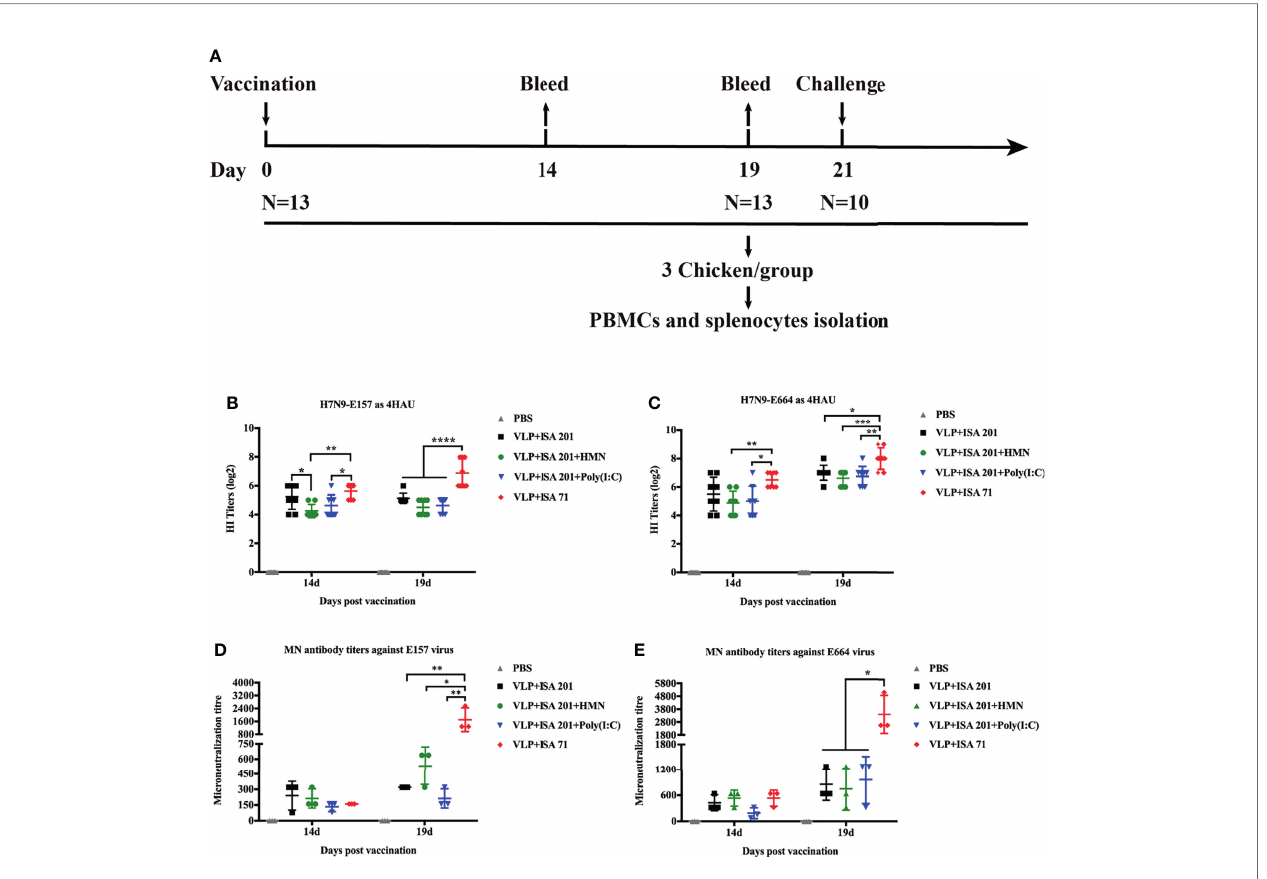
FIGURE 5 | Hemagglutinin inhibition (HI) and neutralizing antibody titers of immune sera from vaccinated speci fi c pathogen-free (SPF) chickens. (A) The timeline and vaccination and challenge study in chicken. SPF chickens were immunized with H7N9 VLP vaccine candidates, and the serum samples were collected 14 and 19 days after immunization. The HI titers of SPF chicken sera were measured with 4 HAU of E157 (B) and E664 (C) . Viral neutralizing antibody titers in serum were determined with E157 (D) and E664 (E) AIVs. The neutralizing and HI antibody titers among vaccination groups were compared using one-way ANOVA followed by Tukey ’ s multiple-comparison test. Statistically signi fi cant differences are indicated by an asterisk as follows: * p < 0.05, ** p < 0.01, *** p < 0.001, or **** p <